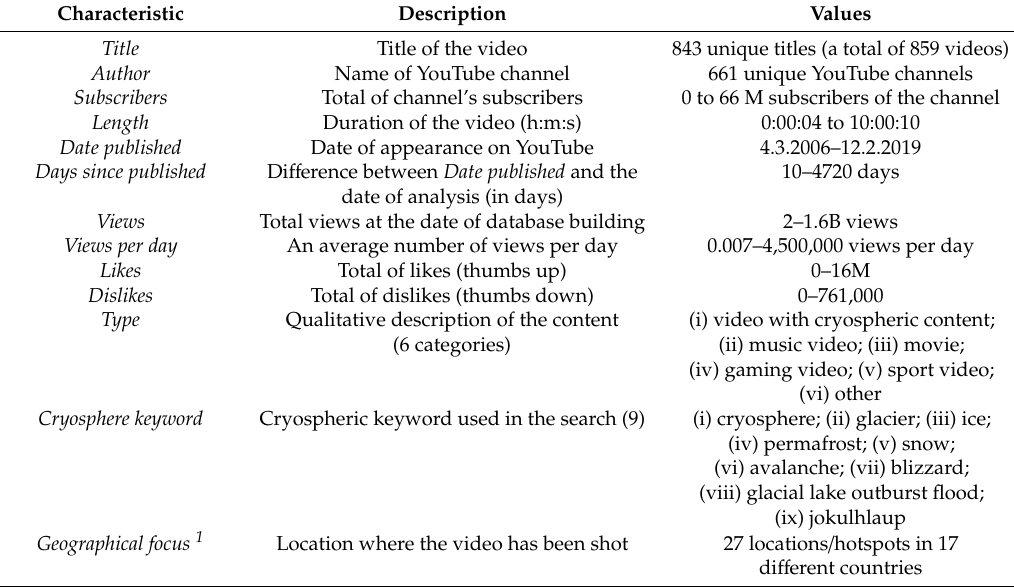
Table 1. Characteristics used to describe each video in the database. The high variability of